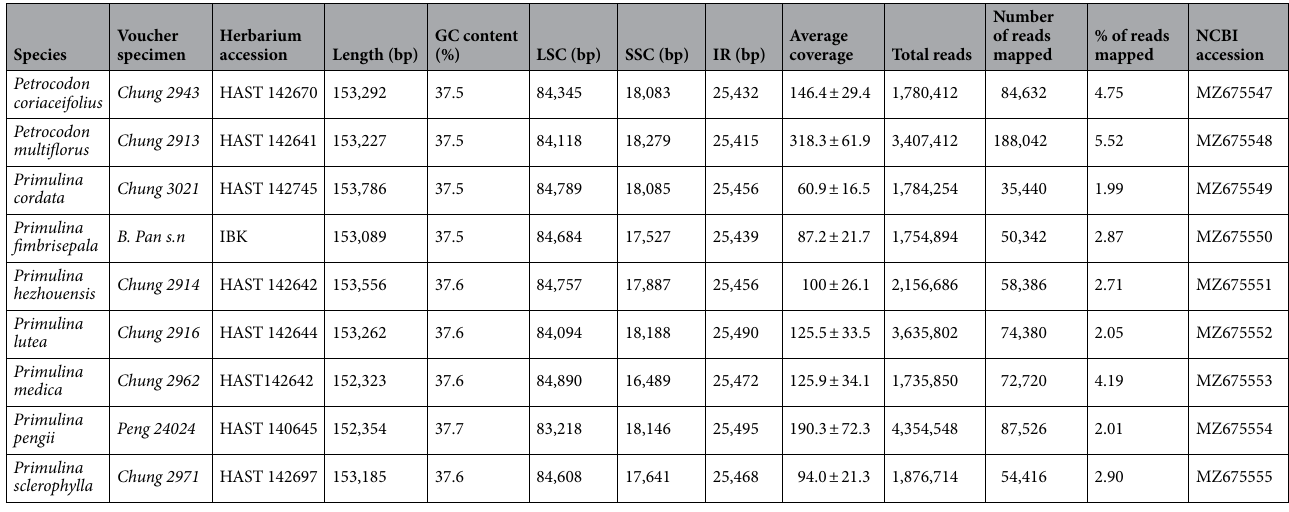
Table 1. Statistics of nine newly generated plastomes of Petrocodon and Primulina . HAST Herbarium of Biodiversity Research Center, Academia Sinica, Taipei, IBK Herbarium of Guangxi Institute of